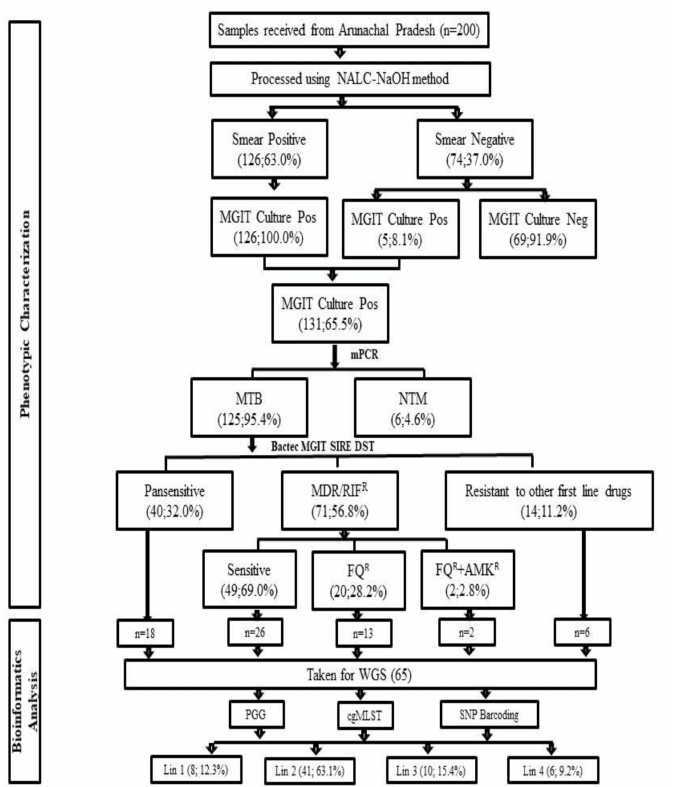
Figure 1. Workflow showing the phenotypic DST result and bioinformatics analysis of the isolates selected for WGS. FQ R : Fluoroquinolone Resistant; AMK R : Amikacin